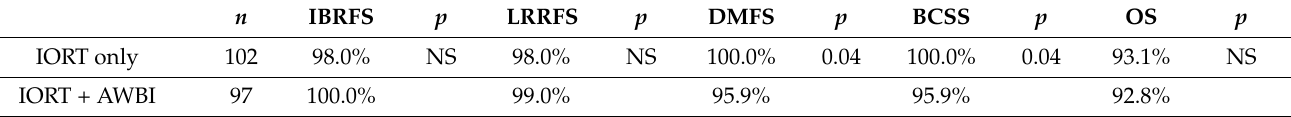
Table 3. Treatment results in patients treated with intraoperative radiotherapy (subgroup analysis).